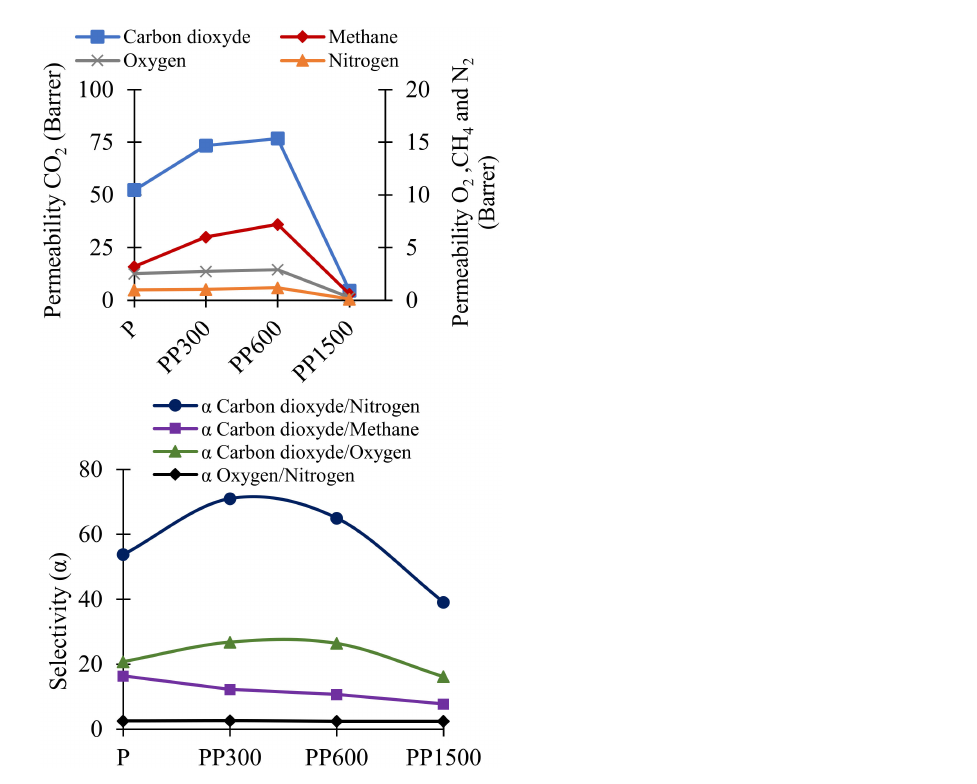
Figure 3. Permeability and selectivity coefficients of CO 2 , CH 4 , N 2 , and O 2 for neat Pebax and Pebax/PEG membranes.